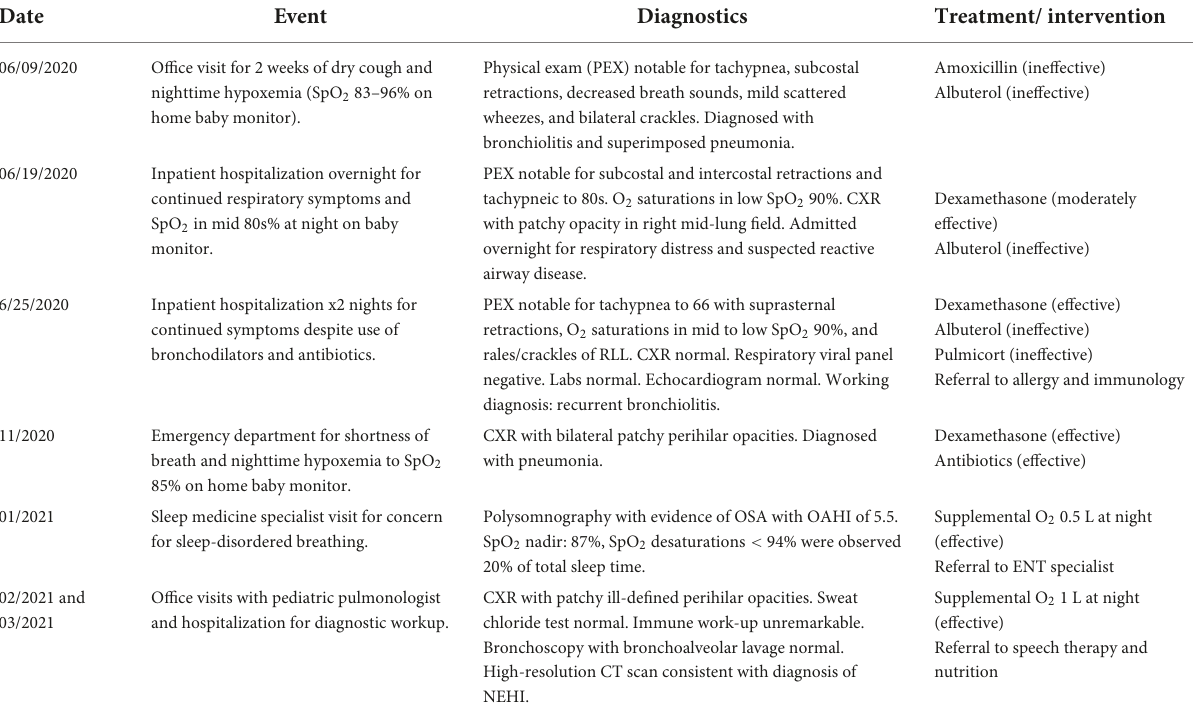
TABLE 1 Timeline of relevant events and interventions leading up to diagnosis of NEHI.